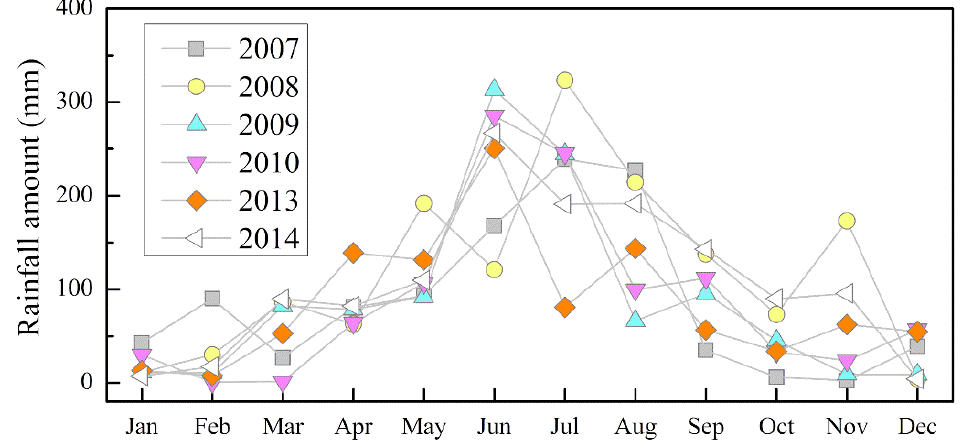
Figure 2. Monthly rainfall amount during the study period.